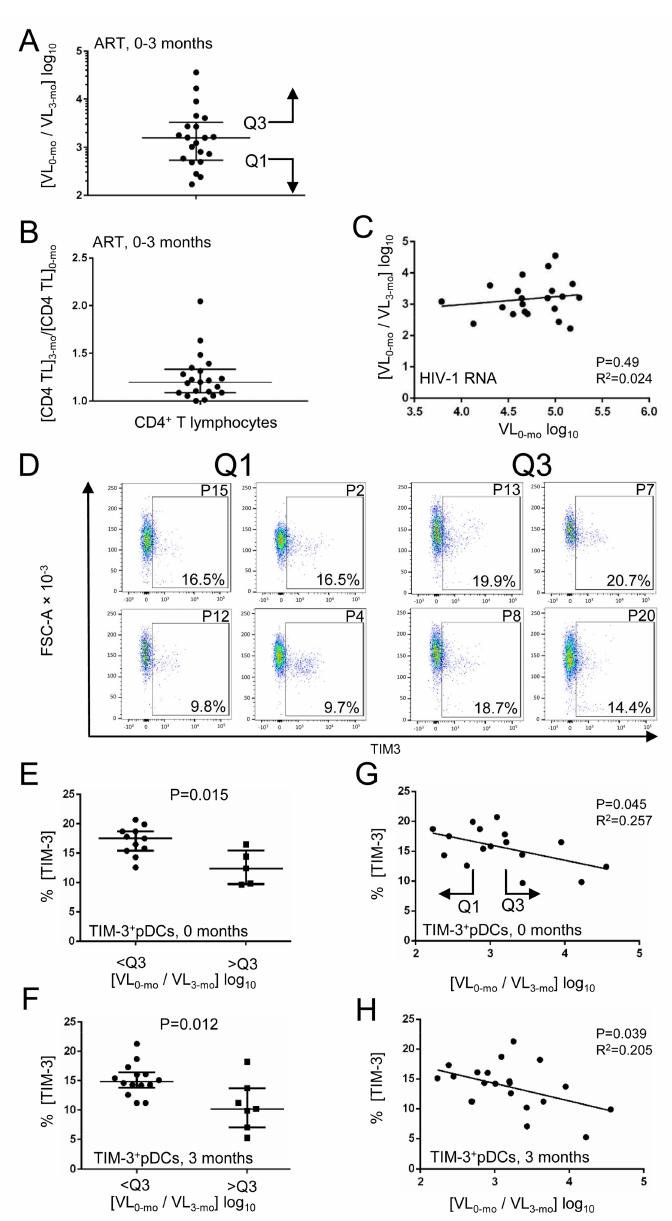
Figure 3. Expression of TIM-3 on pDCs of HIV-1-infected individuals negatively correlates with the rate of decline in HIV-1 RNA copies/mL of plasma over the 3-month ART. ( A ) The rate of decline in HIV-1 virus load (VL) expressed as [VL 0-mo /VL 3-mo ] log 10 , where VL 0-mo is HIV-1 RNA copy number/mL in treatment-naïve individuals (zero time of ART) and VL 3-mo is HIV-1 RNA copy number/mL after 3 months of ART in the cohort of 21 HIV-1-infected individuals. ( B ) The recovery rate of CD4 + T cells in HIV-1-infected individuals expressed as a ratio of CD4 T cell number after 3 months of ART [CD4 TL] 3-mo to CD4 T cell number at zero time of ART [CD4 TL] 0-mo . ( C ) The rate of decline in HIV-1 RNA copies/mL does not correlate with HIV-1 VL in treatment-naïve individuals (zero time of ART). ( D ) Examples of dot plots for the quantification of TIM3 in Lin − BDCA-2 + -gated live pDCs are shown for PBMCs from treatment-naïve individuals from Q1 (patients P2, P4, P12, P15) and Q3 (patients P7, P8, P13, P20). ( E , F ) Comparison of the frequency of TIM-3 + pDCs in treatment-naïve HIV-1-infected patients ( E ) or patients after the 3-month ART ( F ), in which [VL 0-mo /VL 3-mo ] log 10 was <Q3 or >Q3. ( G , H ) Correlation of the frequency of TIM-3 expressed on pDCs in treatment-naïve HIV-1-infected patients ( G ) or patients after the 3-month ART ( H ) with [VL 0-mo /VL 3-mo ] log 10 (the same samples as in panels ( E , F ) were analyzed). The data show medians and interquartile ranges. Q1, the first quartile; Q3, the third quartile; p < 0.05 was considered to be significant; two-tailed Mann–Whitney